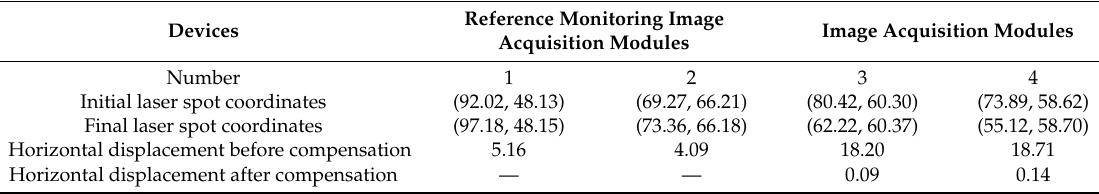
Table 5. Laser transmitter module feasibility test data (unit: mm).